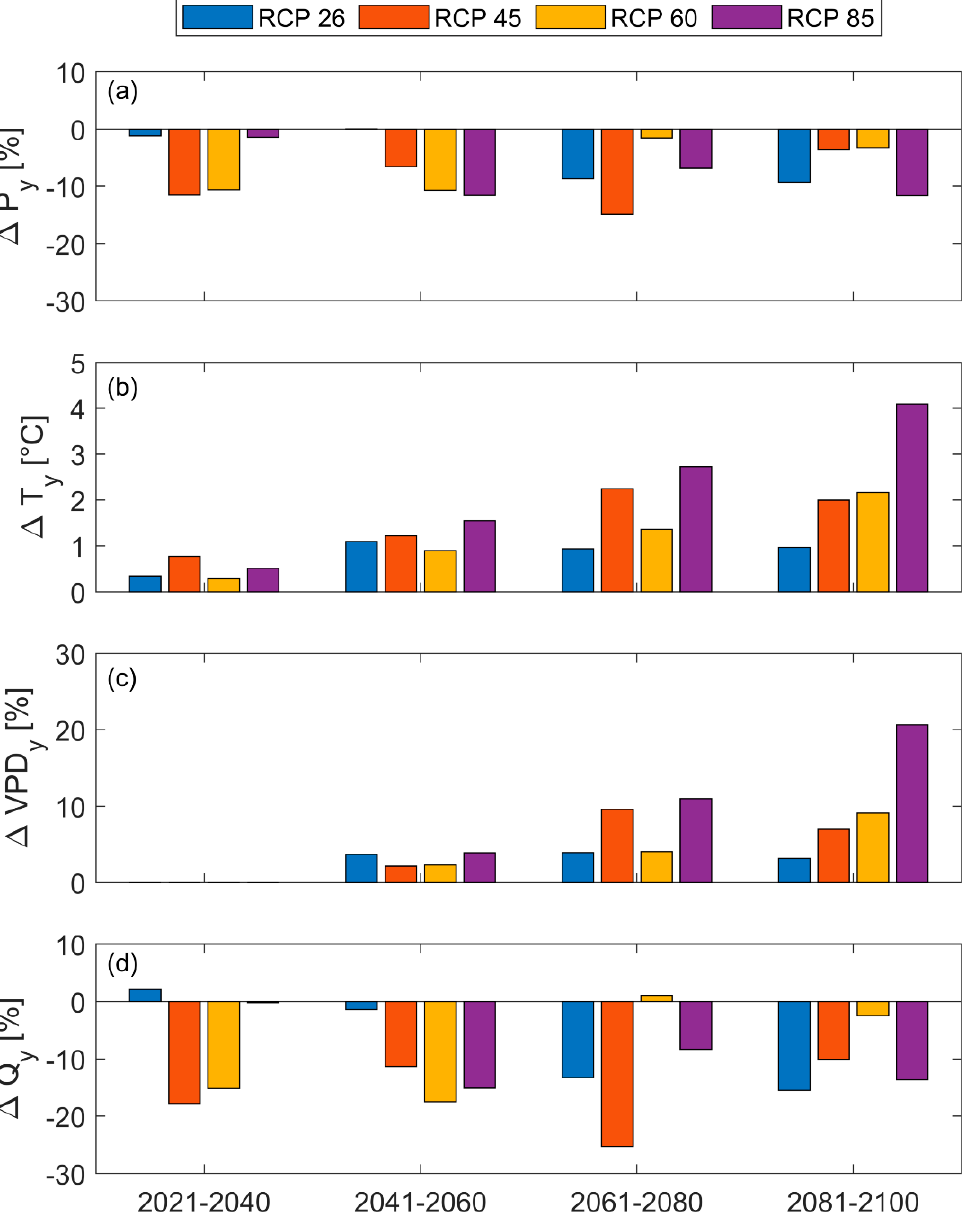
Figure 9. In the Rio Fluminimaggiore basin, mean predicted changes in the future with respect to the historical 2000 − 2020 period of: ( a ) annual precipitation ( Δ P y ), ( b ) annual air temperature ( Δ T y ), ( c ) annual vapor pressure deficit ( Δ VPD y ) and ( d ) annual runoff ( Δ R y ).